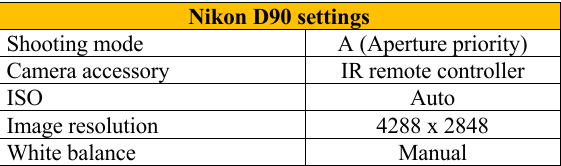
Table 3. Manual camera settings.